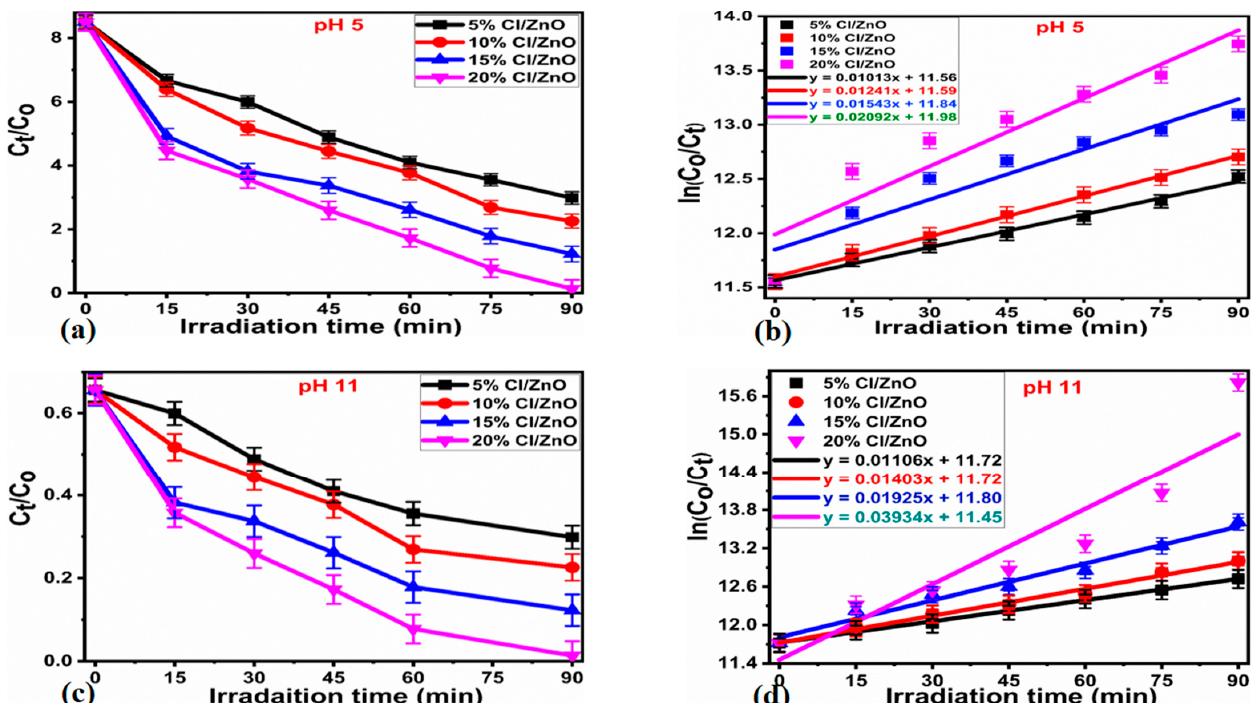
Figure 9. ( a , c ) C t /C o versus time, indicating a decreasing trend for 5%, 10%, 15% and 20% Cl − -doped ZnO at pH 5 and 11, respectively. ( b , d ) Linearly fitted graph Ln (C o /C t ) versus time, showing increasing degradation rates for 5%, 10%, 15% and 20% Cl − -doped ZnO at pH 5 and 11, respectively.